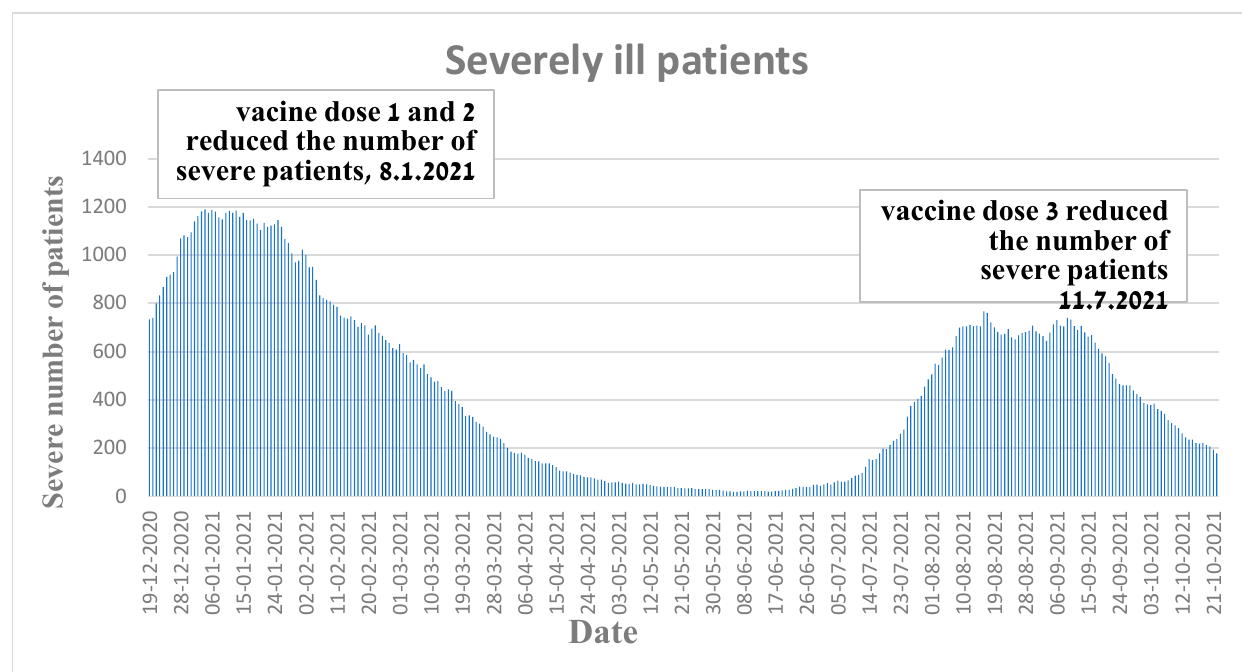
Figure 4. Amount of severely ill patients in Israel during two waves.